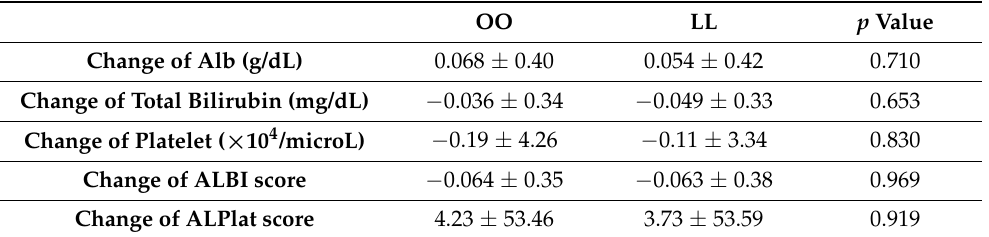
Table 4. Comparison between OO group and LL group: Changes in indicators for liver function before and after RLR.